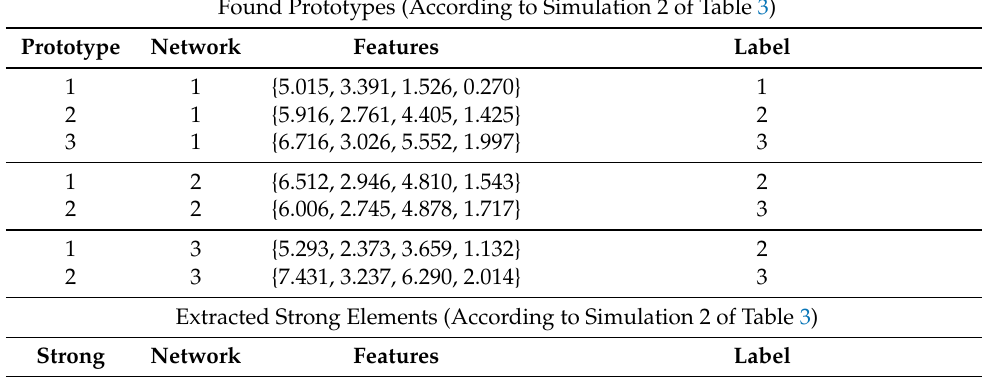
Table 5. Found prototypes and extracted strong elements according to simulation 2 of Table 3. Found Prototypes (According to Simulation 2 of Table